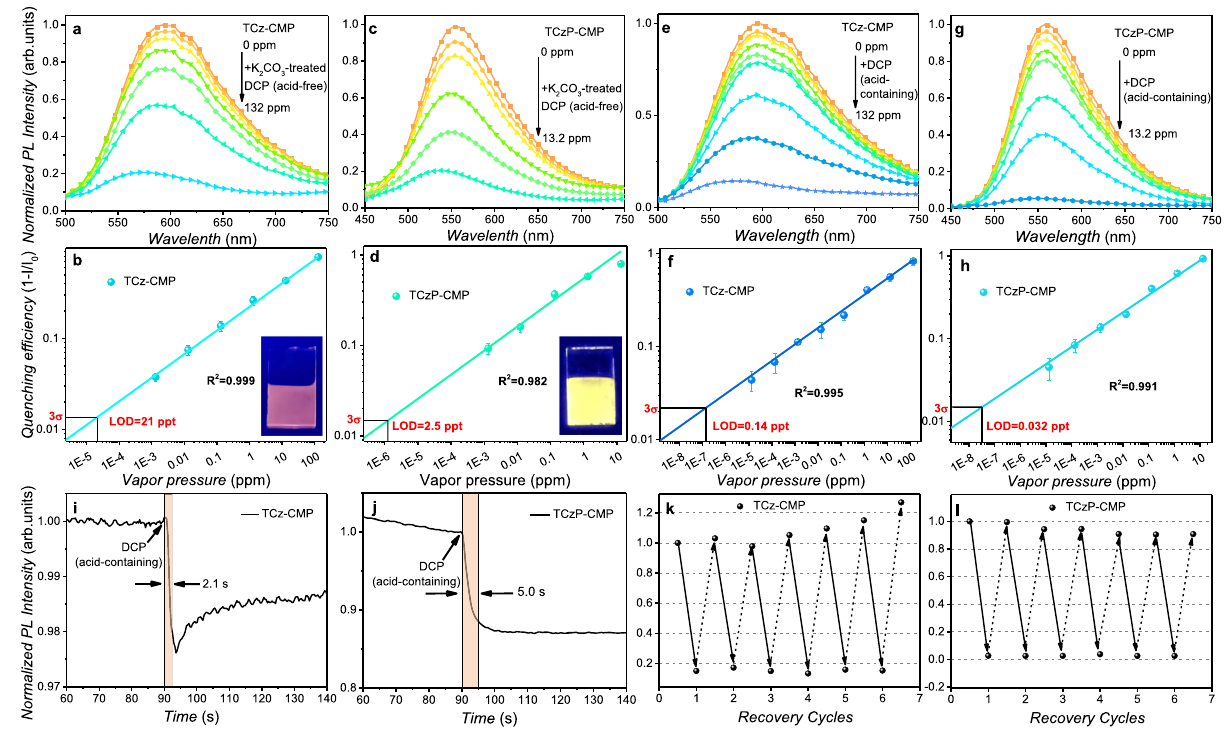
Fig.5|SensingperformanceofCMP fi lms.a , c The fl uorescence intensityofTCz- CMP and TCzP-CMP fi lms to K 2 CO 3 -treated DCP vapors (acid-free). b , d The quenching ef fi ciency of TCz-CMP and TCzP-CMP fi lms exposed to K 2 CO 3 -treated DCPvapors(acid-free);theinsetisaphotoofCMP fi lmsexcitedat365nm. e , g The fl uorescence intensity of TCz-CMP and TCzP-CMP fi lms to acid-containing DCP vapors. f , h The quenching ef fi ciency of TCz-CMP and TCzP-CMP fi lms exposed